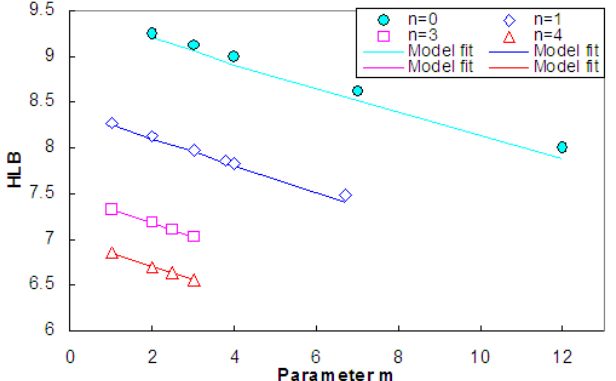
Figure 10. HLB for the polyglycols as function of m for a given n.